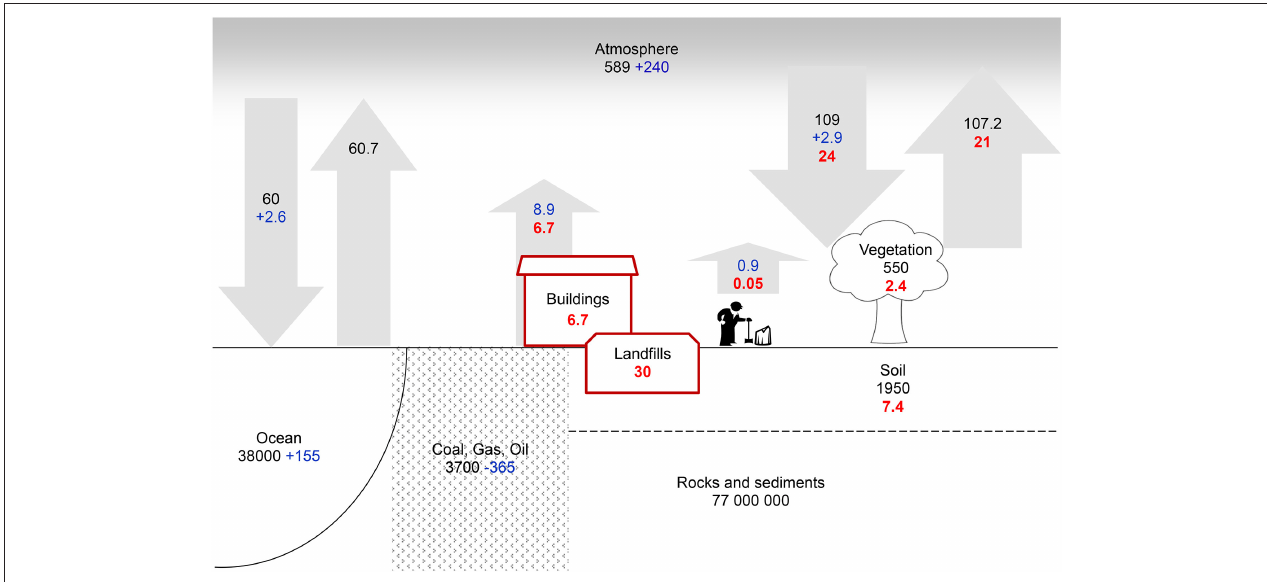
FIGURE 2 | Carbon pools (PgC) and fluxes (PgC/year) of urban areas as compared to the major global carbon fluxes. Urban contributions to the global carbon fluxes as well as to the carbon storage pools in vegetation and soils are highlighted in red. Two new carbon pools created as a result of urbanization are buildings and landfills. They are depicted in red. The global C pools such as atmosphere, vegetation, soil, ocean, fossil fuels, rocks, and sediments are indicated with respective names and amounts of C stored. The global C fluxes such as carbon uptake and release are ocean/land, burning fossil fuels, and land use changes are shown in gray. Estimates for pre-industrial carbon pools and fluxes for preindustrial times are depicted with black font. Changes in these pools and fluxes from preindustrial times as well as the fluxes from burning fossil fuels and changes in land use are shown in blue font (after Ciais et al., 2013; Le Quéré et al., 2015).